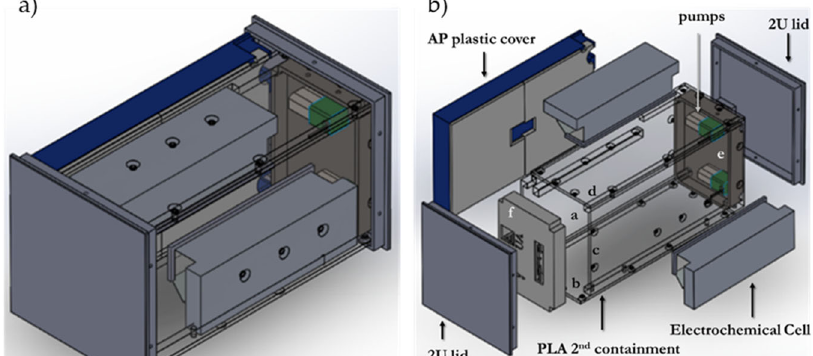
Fig. 4 Ammonia Electrooxidation Lab at the ISS (AELISS) device. a Illustration of the closed AELISS device and b schematic Isometric view of the plastic protective frame with the electrochemical cells. The AELISS had a potentiostat and its plastic cover, plastic protector box frame, two electrochemical cell arrays, two screen-printed electrodes (SPE), two peristaltic pumps, and a storage